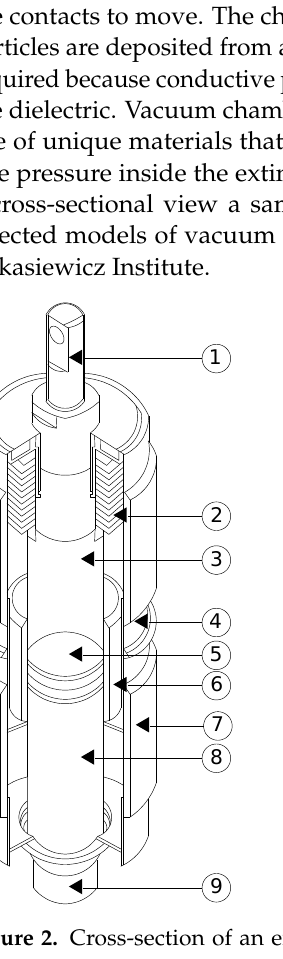
Figure 3. Vacuum chambers used in switchgear [49]. The development of vacuum apparatus technology, as well as the research carried out, has not overlooked one of the most important aspects of development work on vacuum technology — the aspect of pressure control in vacuum chambers. 3. Pressure Control in Switchgear The control of the pressure level in gas-insulated apparatus is extremely important, as the vacuum retains its excellent insulating properties only up to a pressure level of 1 Pa, once the pressure increases beyond this value the breakdown voltage of the insulat- ing gap drops dramatically [50 – 52]. This situation is shown in Figure 4 [18,53].